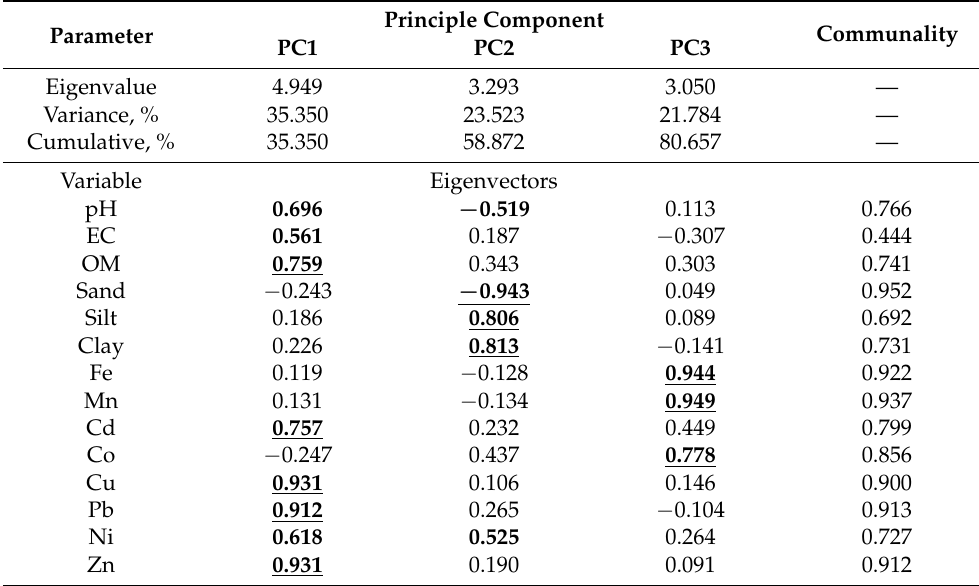
Table 3. Varimax rotated component matrix of the studied soil